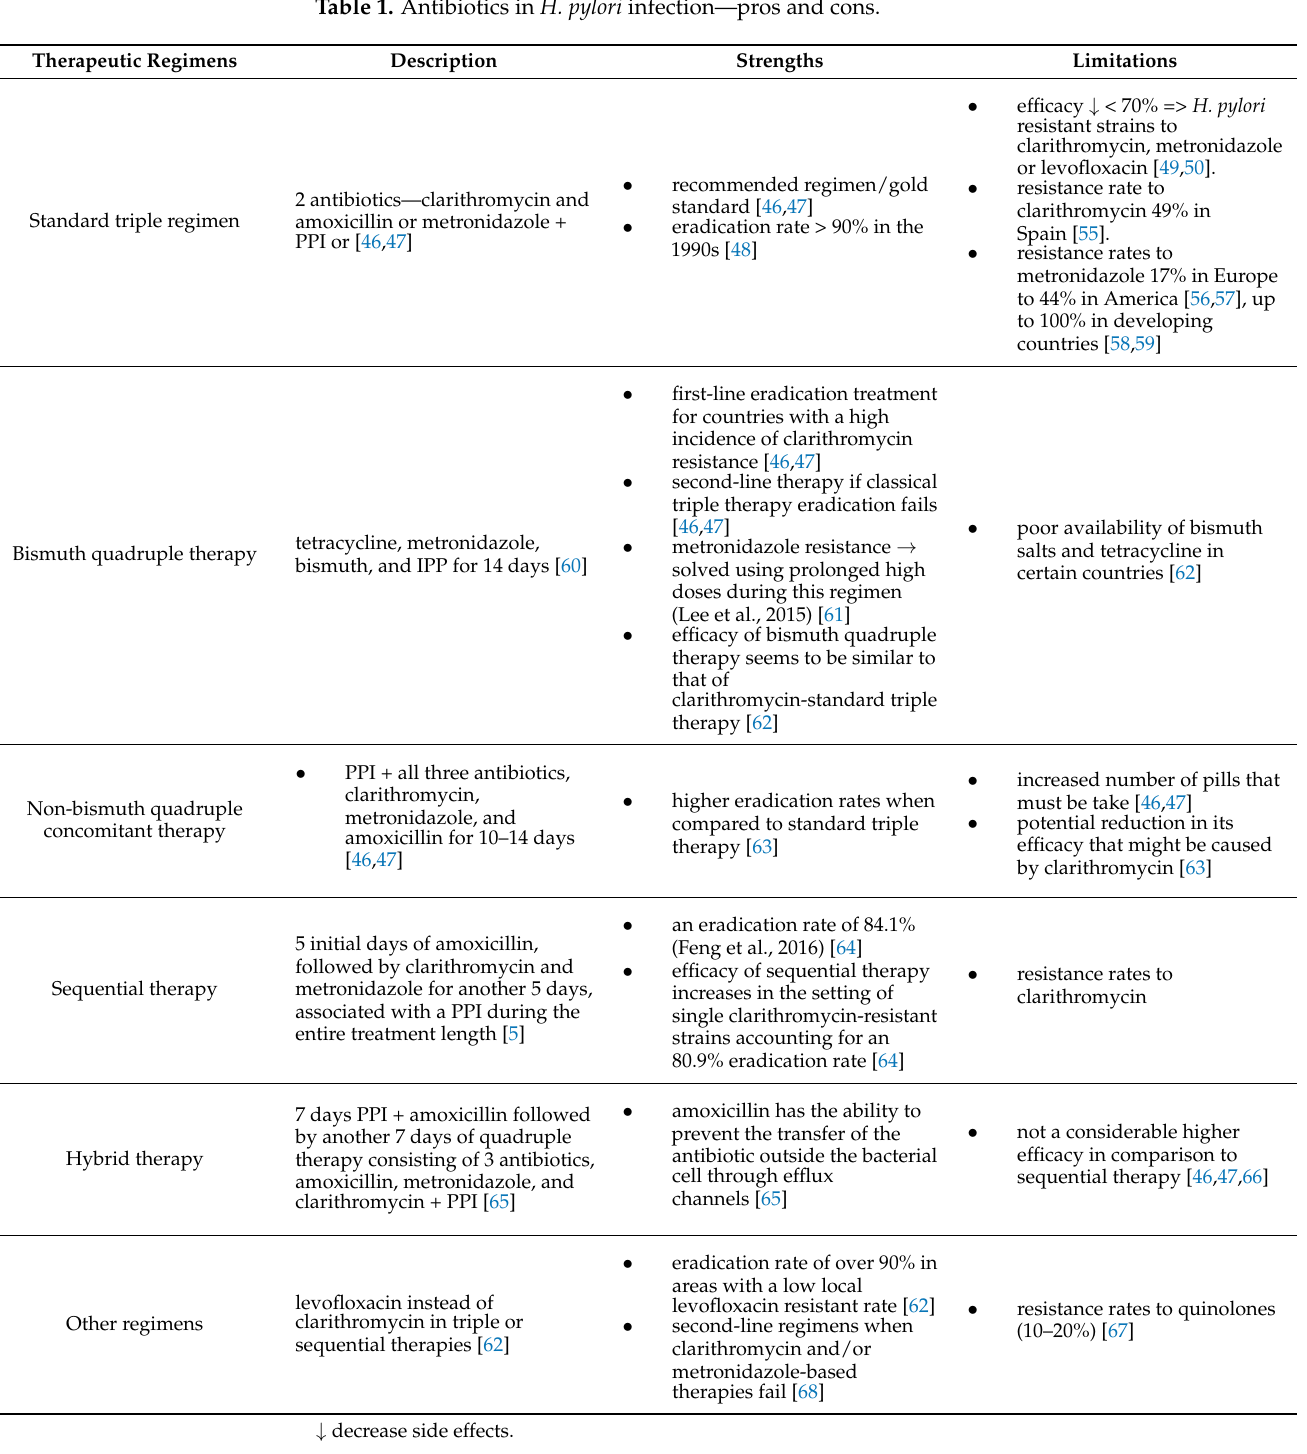
Table 1. Antibiotics in H. pylori infection—pros and